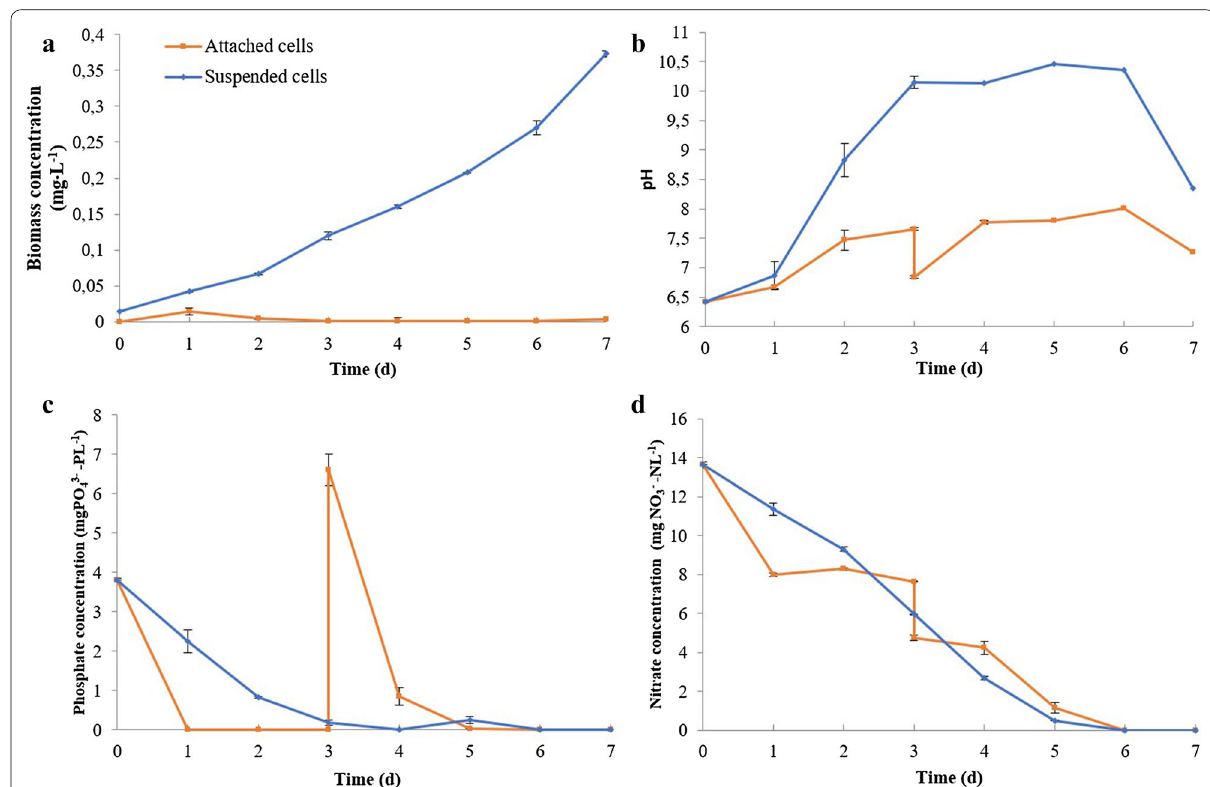
Fig. 2 a Biomass growth, b pH changes in liquid, c phosphorus and d nitrogen removal kinetics of S. vacuolatus ACUF_053 cultivated in suspension and as attached biofilm in PBR. The error bars correspond to the standard